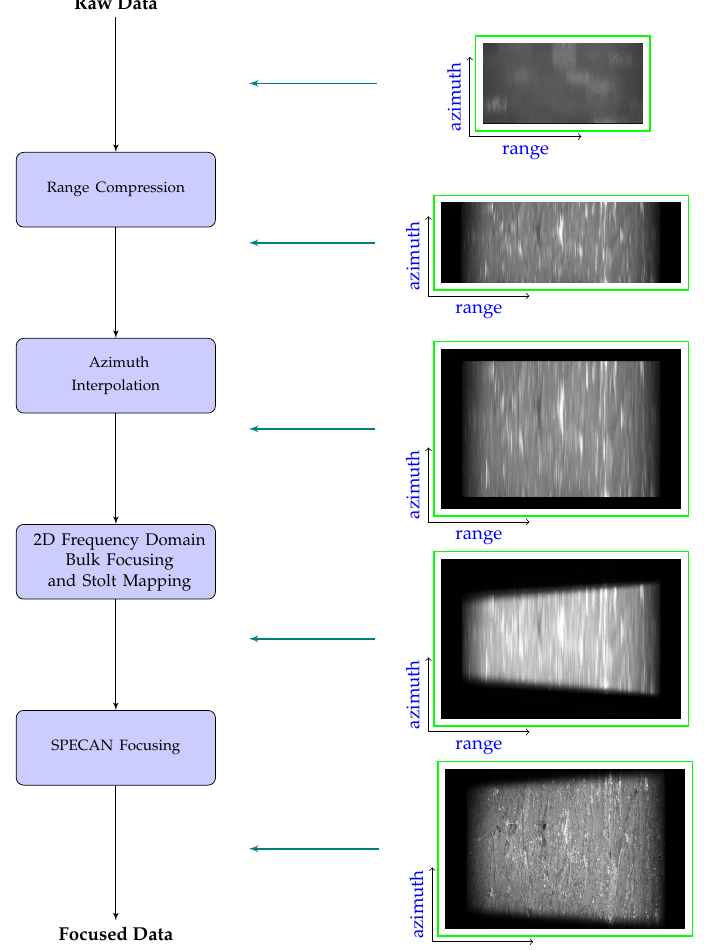
Figure 6. Flow chart of the proposed TOPS raw data focusing algorithm (see Figure 5b), showing the effect of each processing step on the data, starting from raw up to focused data. Please note that the extra zeros shown in the central panel of the Figure have been added only to have an azimuth dimension as power of 2 to efficiently perform the FFT